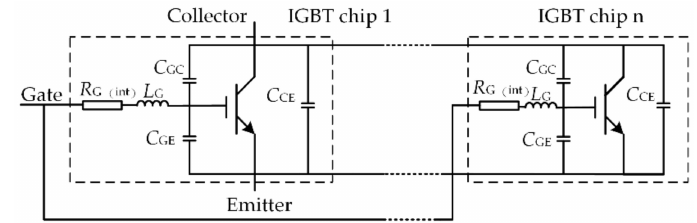
Figure 2. Internal structure diagram of multi-chip IGBT module.